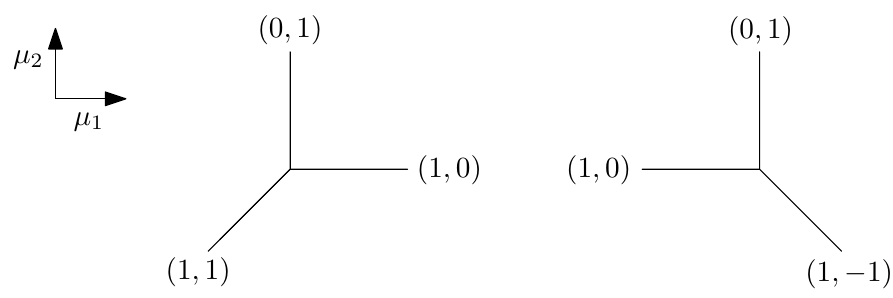
Figure 1. Toric diagram of CY 3